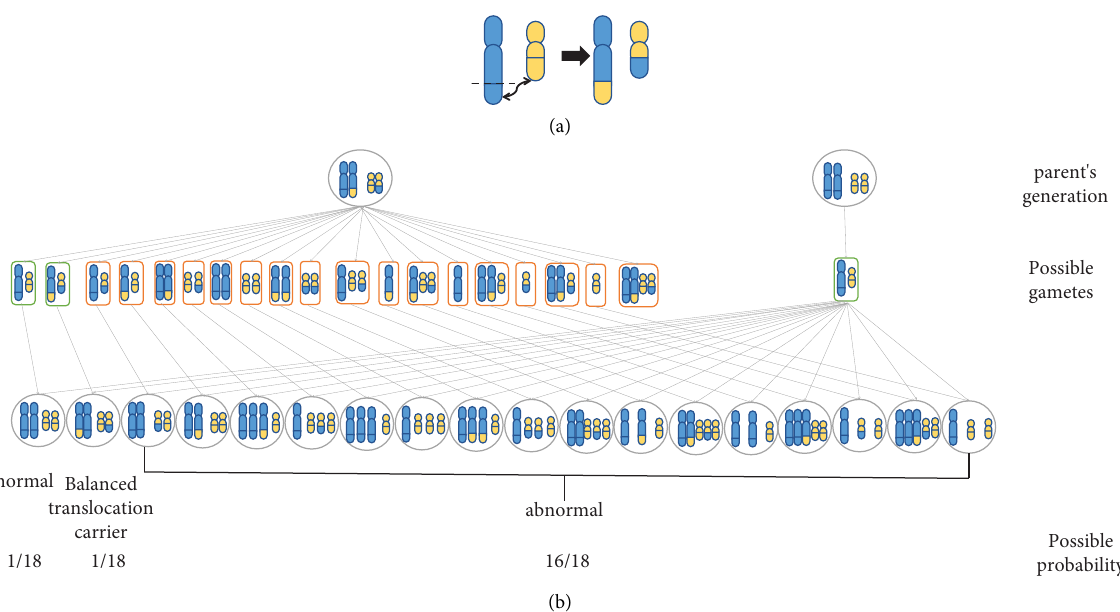
Figure 1: (a) Balanced translocations on nonhomologous chromosomes. (b) Possible gametes in patients with balanced translocations. During meiosis I, the translocated chromosome combines with its normal homologous chromosome to form a tetrad. Balanced gametes containing normal non-homologous chromosomes or two translocated chromosomes resulting from alternate segregation are designated by green border, and unbalanced gametes by red border. Chromosome segregation patterns for tetrad are shown: 2:2 (two non-homologous or two homologous chromosomes segregate together in an adjacent-1 or adjacent-2 segregation, respectively), 3:1 (three chromosomes segregate into one cell and one into the other), and 4 :0 (all chromosomes segregate together).